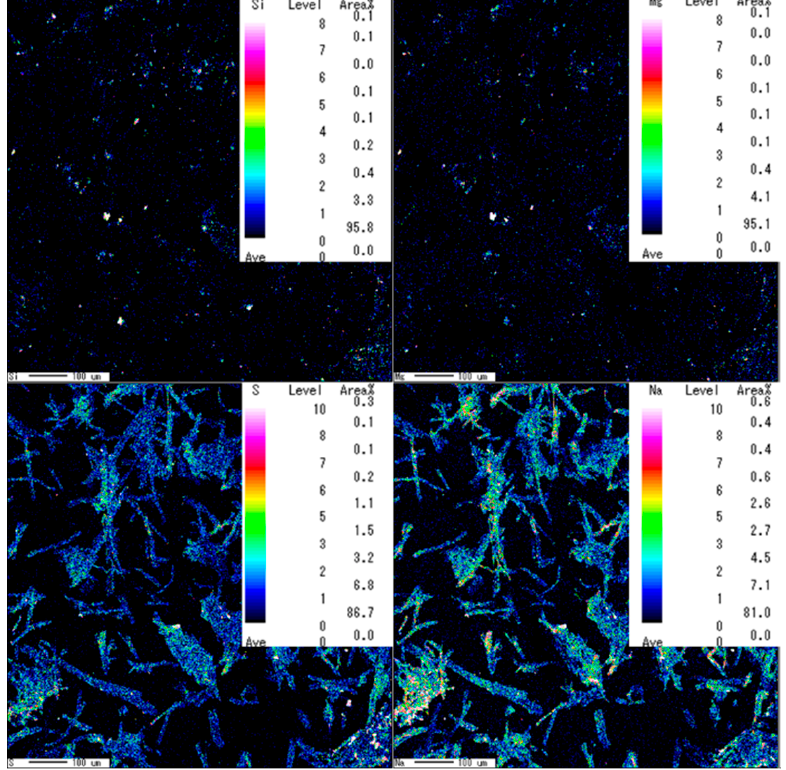
Figure 13. Detection of S and Na in samples: “SA6345-2PN”.